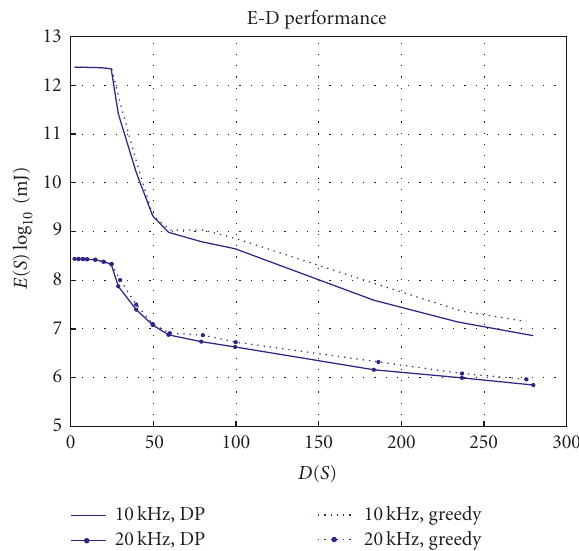
Figure 7: Energy-distortion performance for the maximum distor- tion